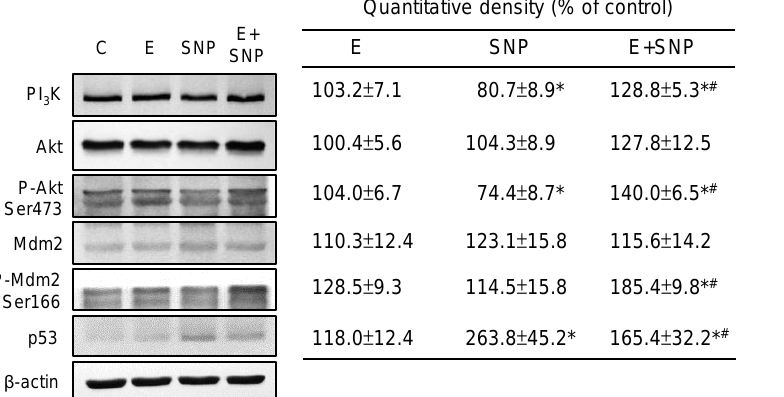
Figure 7. The effects of SNP and/or S-Equol on PI 3 K-Akt pathway of primary chondrocytes. The cells were treated with S-Equol for 24 h in the presence or absence of SNP for another 24 h, and then ( A ) PI 3 K, Akt, P-Akt, Mdm2, P-Mdm2, and p53 protein levels were measured by Western blotting and β-actin was used as the internal control. The data in the right panel are expressed as the relative density compared to the untreated cells (control), which was 100%. ( B ) The cells were pretreated with the 10 μM PI 3 K inhibitor, LY294002 (LY), for 1 h and then treated with 0.8 mM SNP and/or 30 μM S-Equol for a further 24 h and, subsequently, cell viability was measured using trypan blue exclusion. The data are expressed as a percentage of the control group. The results are the mean ± S.D. for three separate experiments. * p < 0.05 compared to the corresponding untreated control. # p < 0.05 compared to the corresponding SNP treated group. p < 0.05 compared to the corresponding S-Equol combined with SNP treated group.